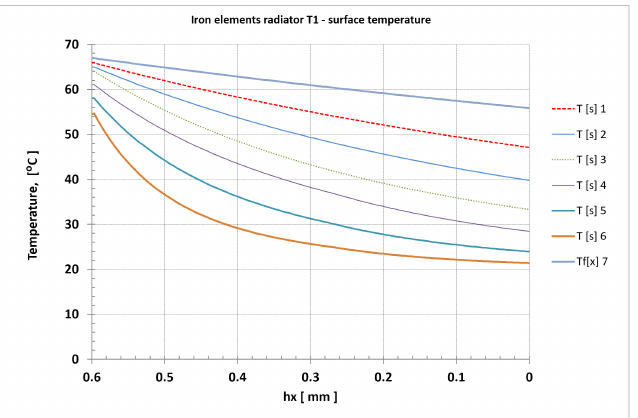
Figure 18. Iron Element Radiator T1 type —surface temperature distribution according simulation calculations , t s = 89.7 ◦ C, mass flow q mx from 24% to 153% nominal value. The comparison between the measurement and simulation calculations result of ra- diator heat output, radiator e f f iciency and return water temperature according to the NEHTMiR md for 2-row plate radiator Delonghi 22 with extended external surface (ribbed degree around 4.76) at t s = 89.8 ◦ C and radiator water mass flow rate from 0.0059 kg/s, 24% (nominal value) to 0.0379 kg/s, 153% (nominal value) are presented in the Tables 3 and 4. Table 3. The comparison between the measurement and the calculations results Radiator Delonghi 22 , t s = 89.8 ◦ C. No.